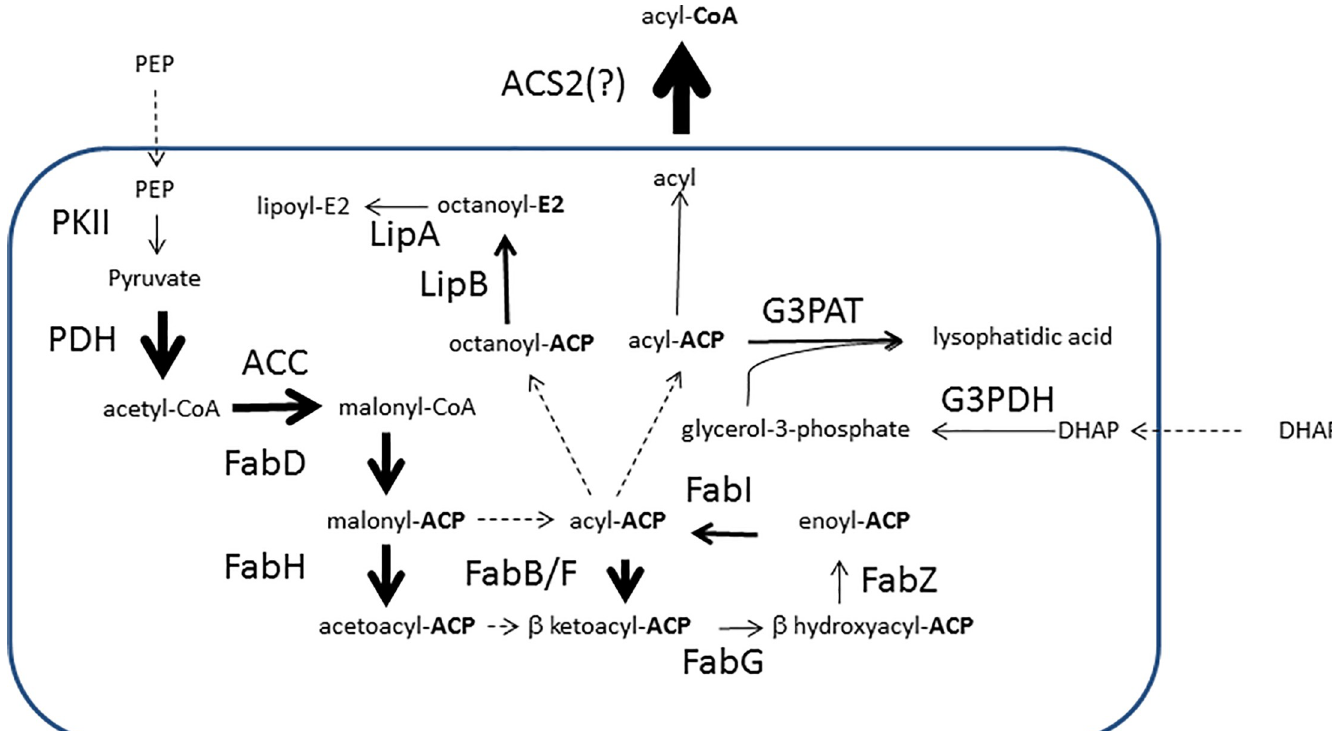
Fig 3. Apicoplast fatty acid synthesis proteins are enriched among sporozoites. The width of the arrows is determined by the Bayesian score reflecting the level of over representation of that enzyme in sporozoites, e.g. 16 for ACS2 and 8 for FabB/F (S3 Table). For PDH that consists of three proteins, the width of the arrow was determined by the average of those three. Most of FASII proteins are enriched in sporozoites, except PKII, FABZ and LipA. The scheme is a simplification of the pathway as depicted by Shears et al .[50], to which ACS2 was added as it is highly enriched in sporozoites and relevant for fatty acid synthesis.